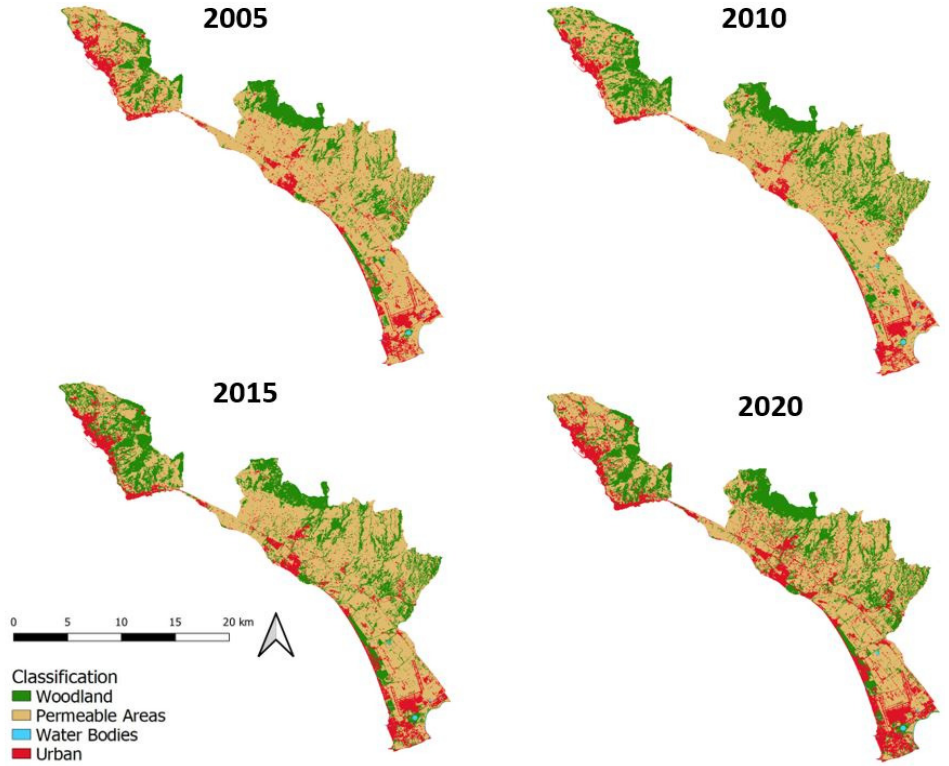
Figure 7. Land cover classification by RF algorithm. Years: 2005, 2010, 2015, and 2020. LC classifica- tions were sieved in QGIS, threshold = 5 pixels, 4-bit connectivity.